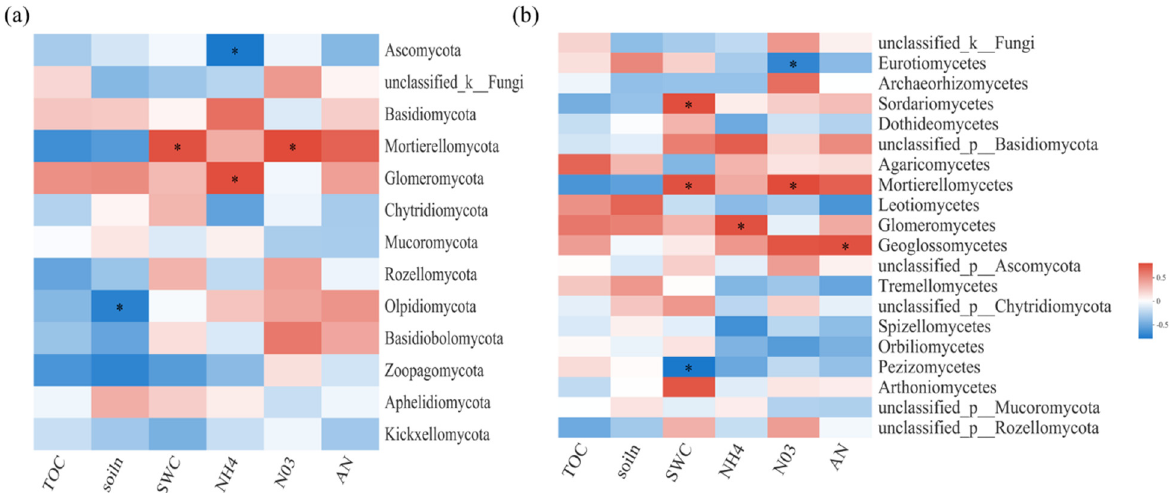
Figure 4. Spearman correlation heatmaps of environment factors, biochemical properties, and fungal gene read numbers at the phylum ( a ) and class ( b ) levels. TOC: organic carbon; NH4: ammonium nitrogen; NO3: nitrate nitrogen; AN: available nitrogen; soiln: total nitrogen. SWC: soil water content. The color intensity in each panel indicates the relative correlation between soil properties and read numbers of each group. Statistically significant correlations are indicated with * p ≤ 0.05.